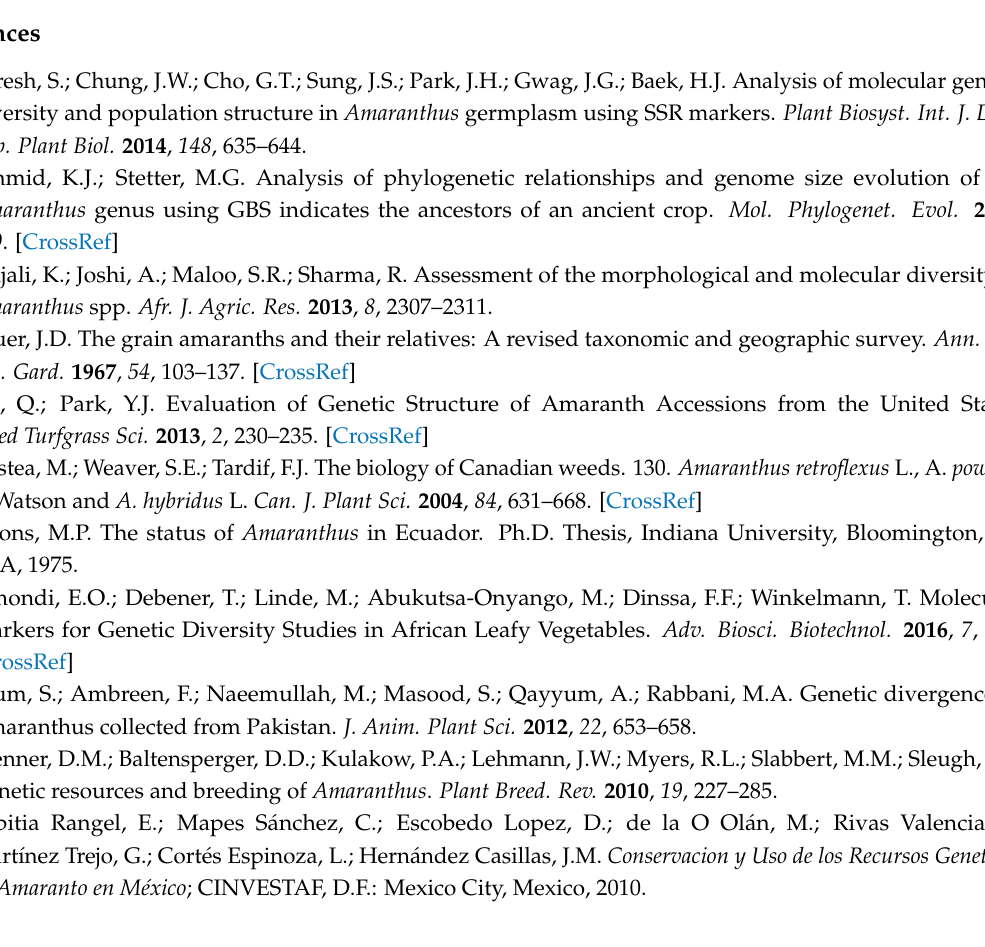
Figure S1: Scan of the SSE collection of amaranth seeds used in this study, Table S1: Entry data for cultivated amaranth accessions from Seed Savers’ Exchange (SSE), Table S2: Passport data of Amaranth accessions from USDA, Table S3: Morphological traits and number given to them, Table S4: Significance of morphological traits on different clusters of all accessions combined across USDA and SSE collections, Table S5: Nearest cluster analysis based on Mahalanobis D 2 distance between groups found among all accessions combined across USDA and SSE Amaranths